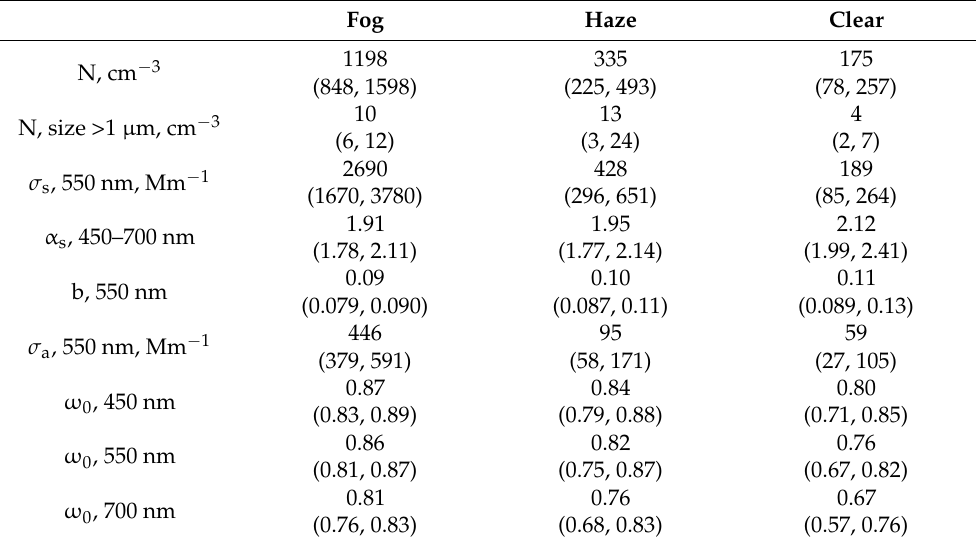
a Median values given in the top line, 10th and 90th percentiles given inside parentheses.